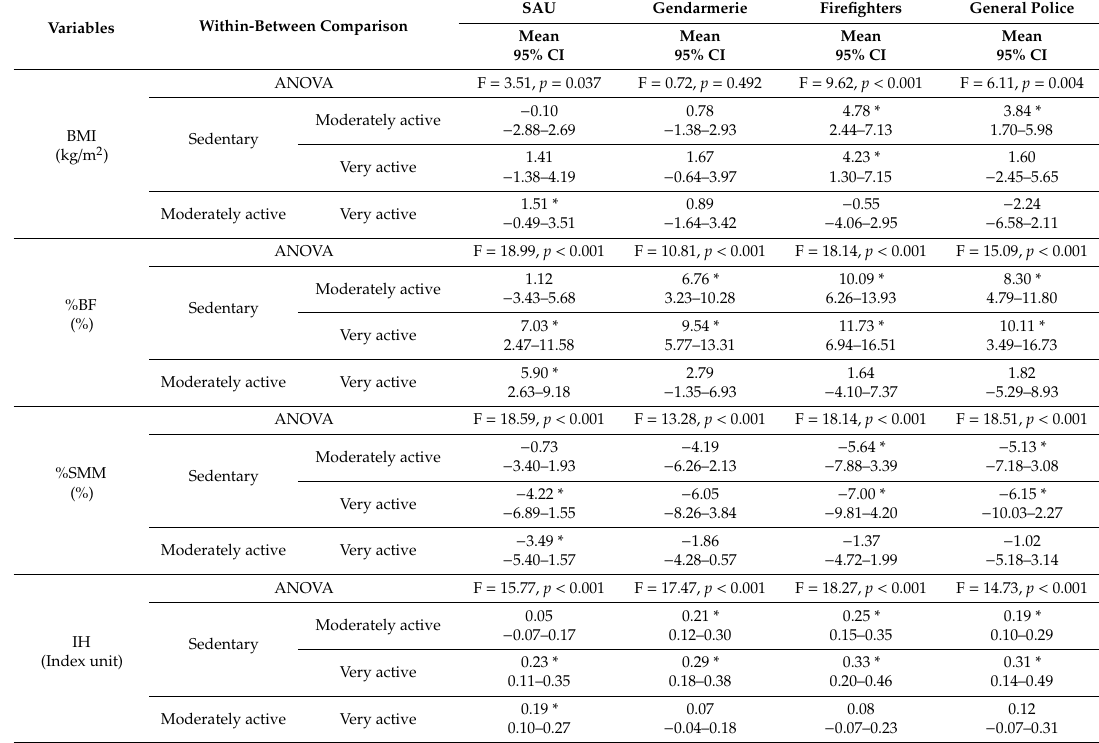
Table 4. Within-occupation di ff erences in body composition relative to leisure-time physical activity obtained by Bonferroni post hoc tests.